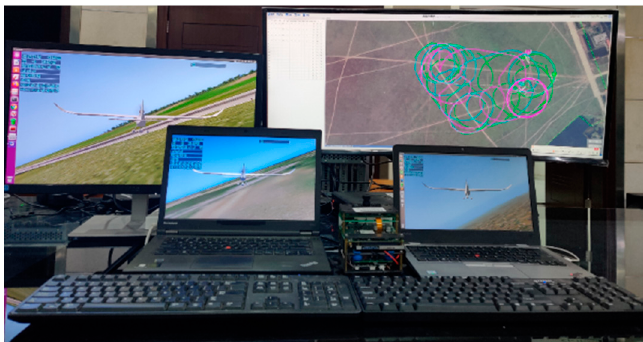
Figure 17. The laptops and onboard computer used in the HIL simulation. The ground control station is in the upper right corner, and other laptops are simulations for UAVs.